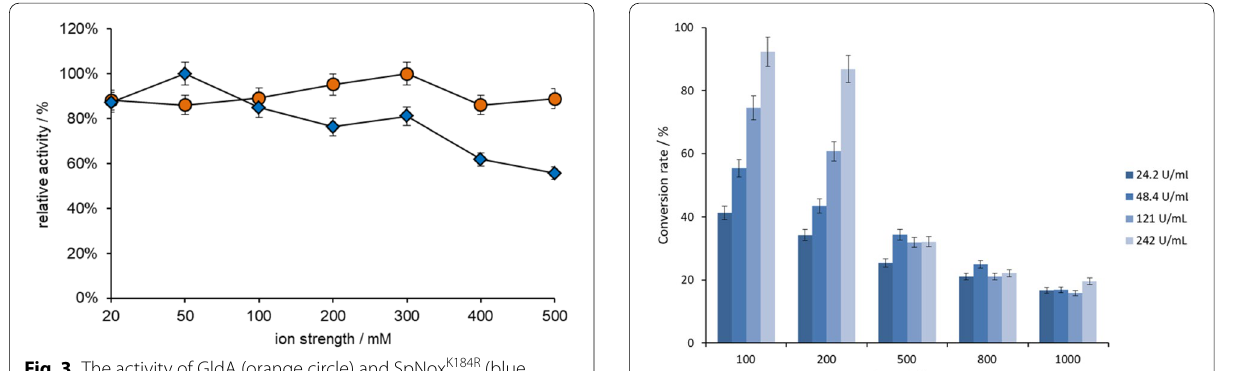
Fig. 3 The activity of GldA (orange circle) and SpNox K184R (blue square) in different concentrations of pH 7.1 potassium phosphate buffer